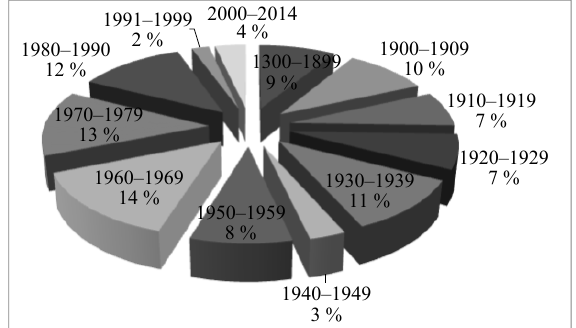
Fig. 2. The proportion of multi-family residential buildings in Latvia (VZD, 2014 b ) [Figure made by the